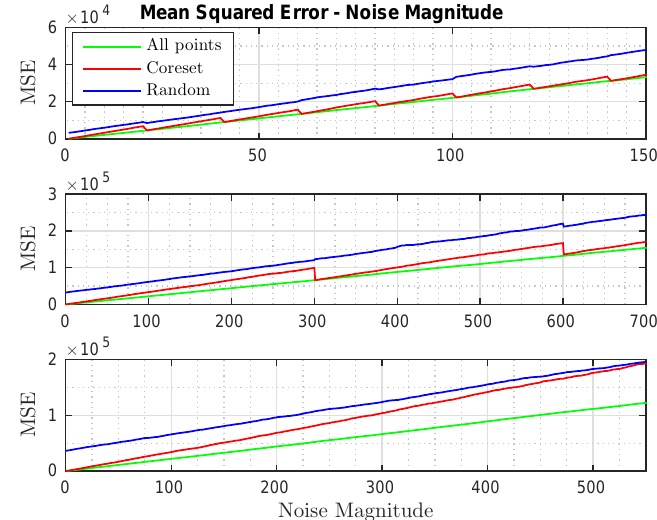
Figure 4. Comparing the results of methods (i), (ii), and (iii). The X -axis represents the noise magnitude m ; see noise data paragraph in Section 6.1. The Y -axis represents the MSE between the two sets after applying the optimal poses obtained from each of the methods.